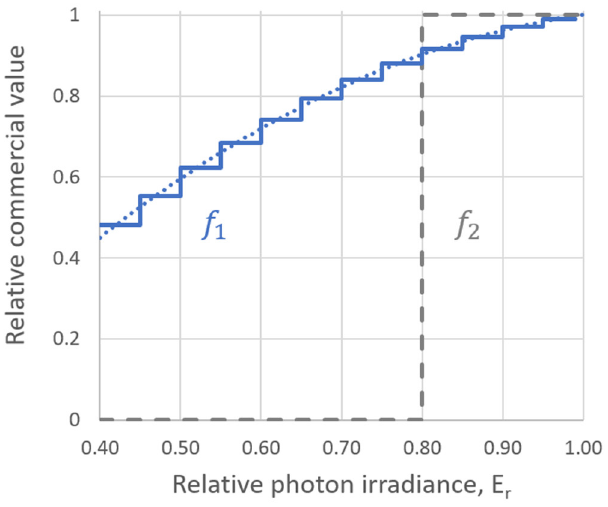
Figure 7. Relative commercial value of the crop as a function of photosynthetic photon irradiance normalized to the target value. Solid blue line ( f 1 ) represents the case when commercial value changes continuously as a function of photon irradiance (e.g., fresh weight of the crop). The gray dashed line ( f 2 ) is the transfer function when crop is sold by piece based on quality attributes.